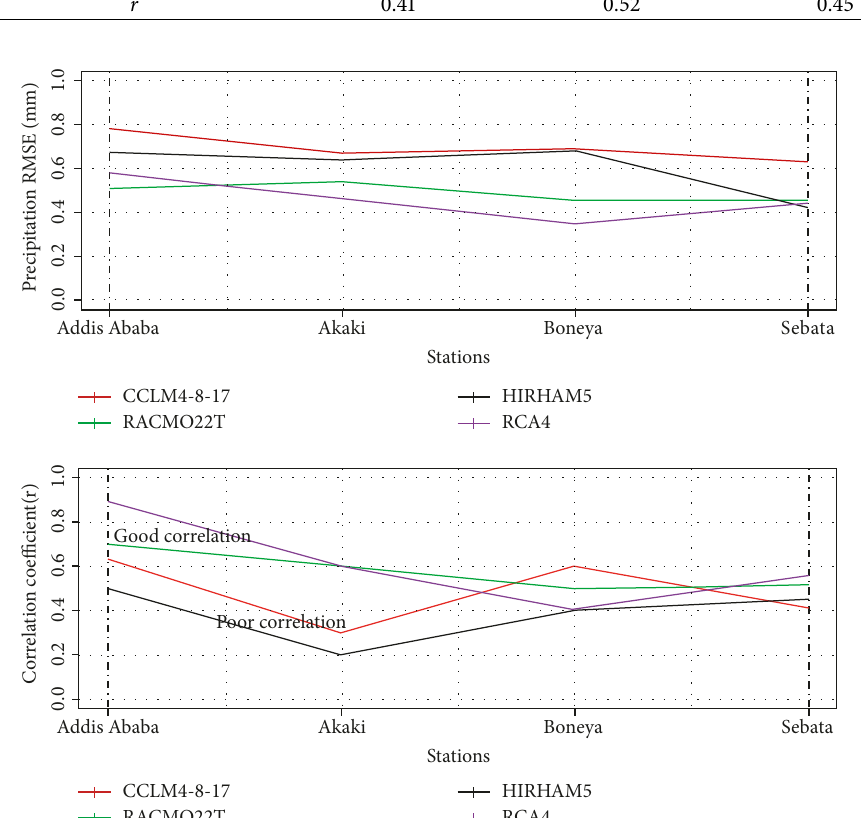
Figure 9: Correlation coefficients ( r ) and RMSE of mean annual precipitation between simulated and observed at Akaki